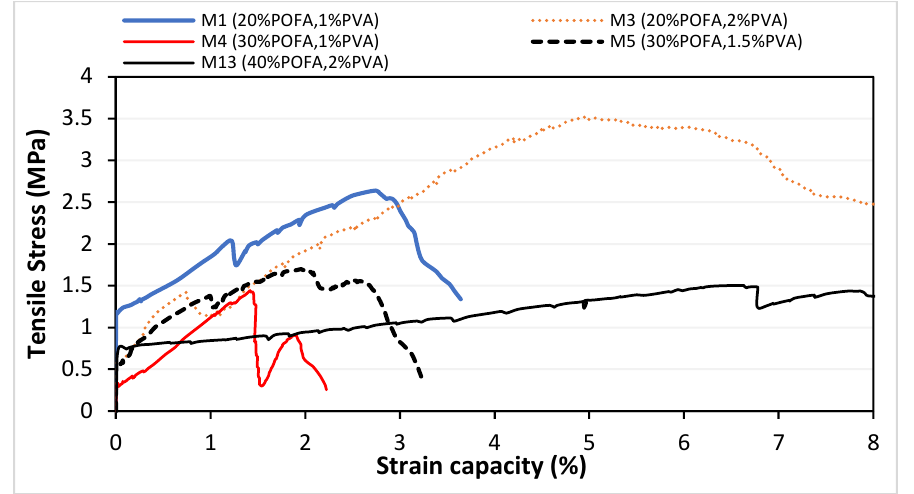
Figure 8. Stress – strain curves for POFA-ECC mixes. Figure 8. Stress–strain curves for POFA-ECC